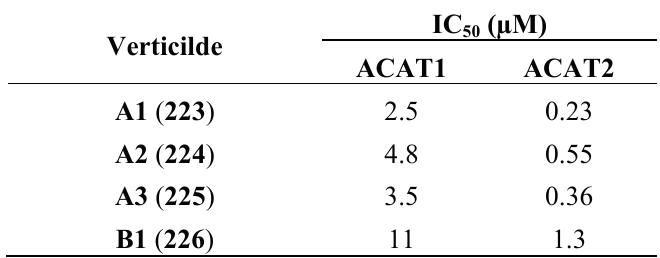
Table 6. Inhibition of cholesterol acetyltransferases ACAT1 and